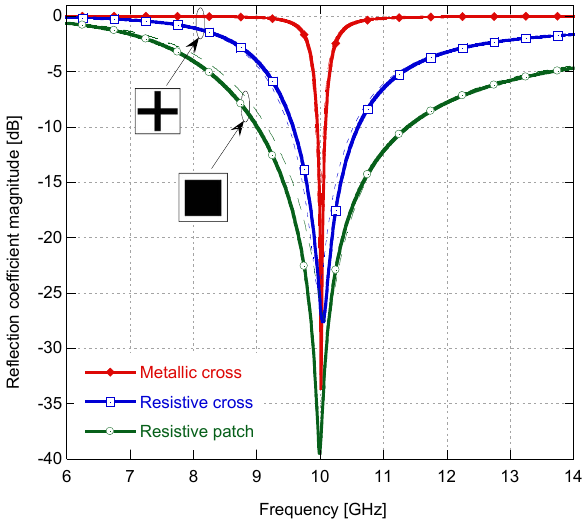
Figure 3 – Reflection coefficient of a High-Impedance Surface absorber comprising both metallic and resistive FSSs. Continuous line: MoM simulation, Dashed line: Transmission line model.